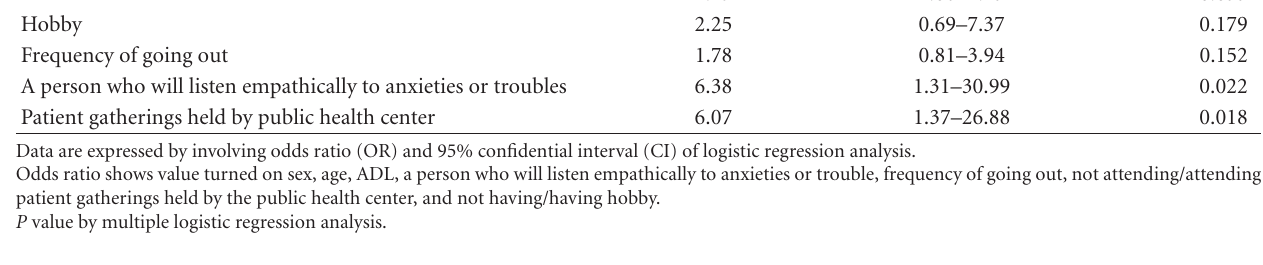
Table 4: Correlates of each domain of WHOQOL-BREF score (low- and high-score